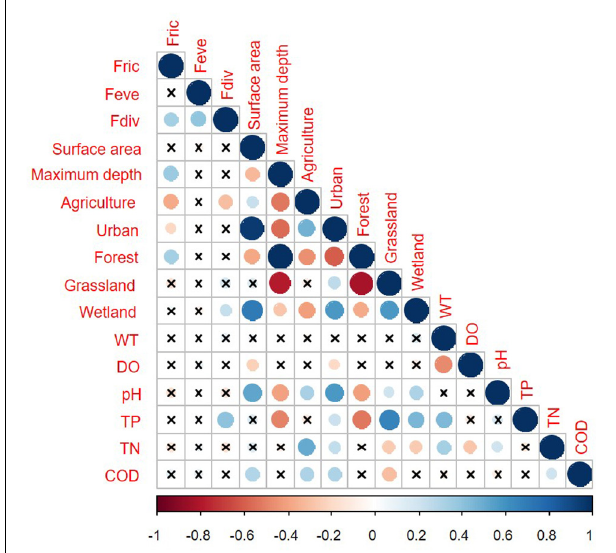
FIGURE 5 | Pearson correlation matrix for the functional diversity indices and morphometric and environmental descriptors. Non-significant correlations ( p > 0.05) are represented by the crossed-out